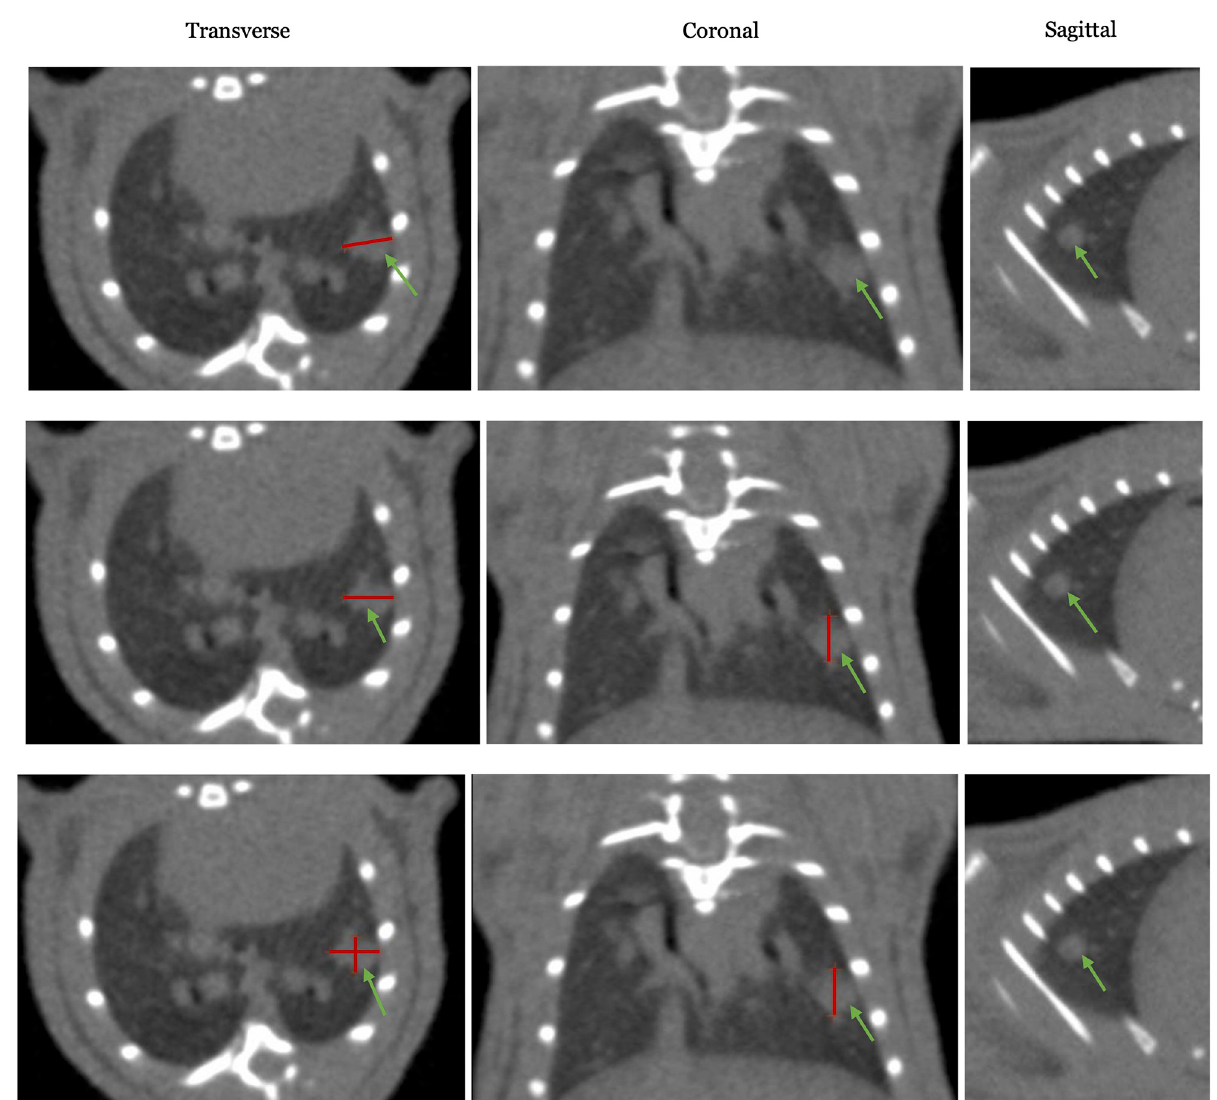
Fig 4. The images feature the transverse (1 st image of every row), coronal (2 nd image of every row), and sagittal (3 rd image of every row) slices of the CT image at the location of the lesion (indicated by the green arrow). Each row of images features methods of measuring (as delineated by red lines) based on the RECIST criteria (1 st row from the top), two-dimensional traditional measurement (2 nd row), and three-dimensional ellipsoid-based measurement (3 rd row).